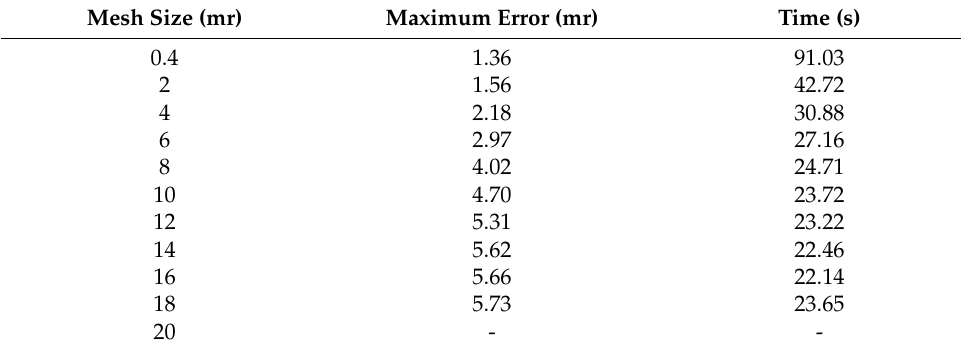
Figure 14. Model error and modeling time at different mesh sizes. Table 1. Model error and modeling time at different mesh